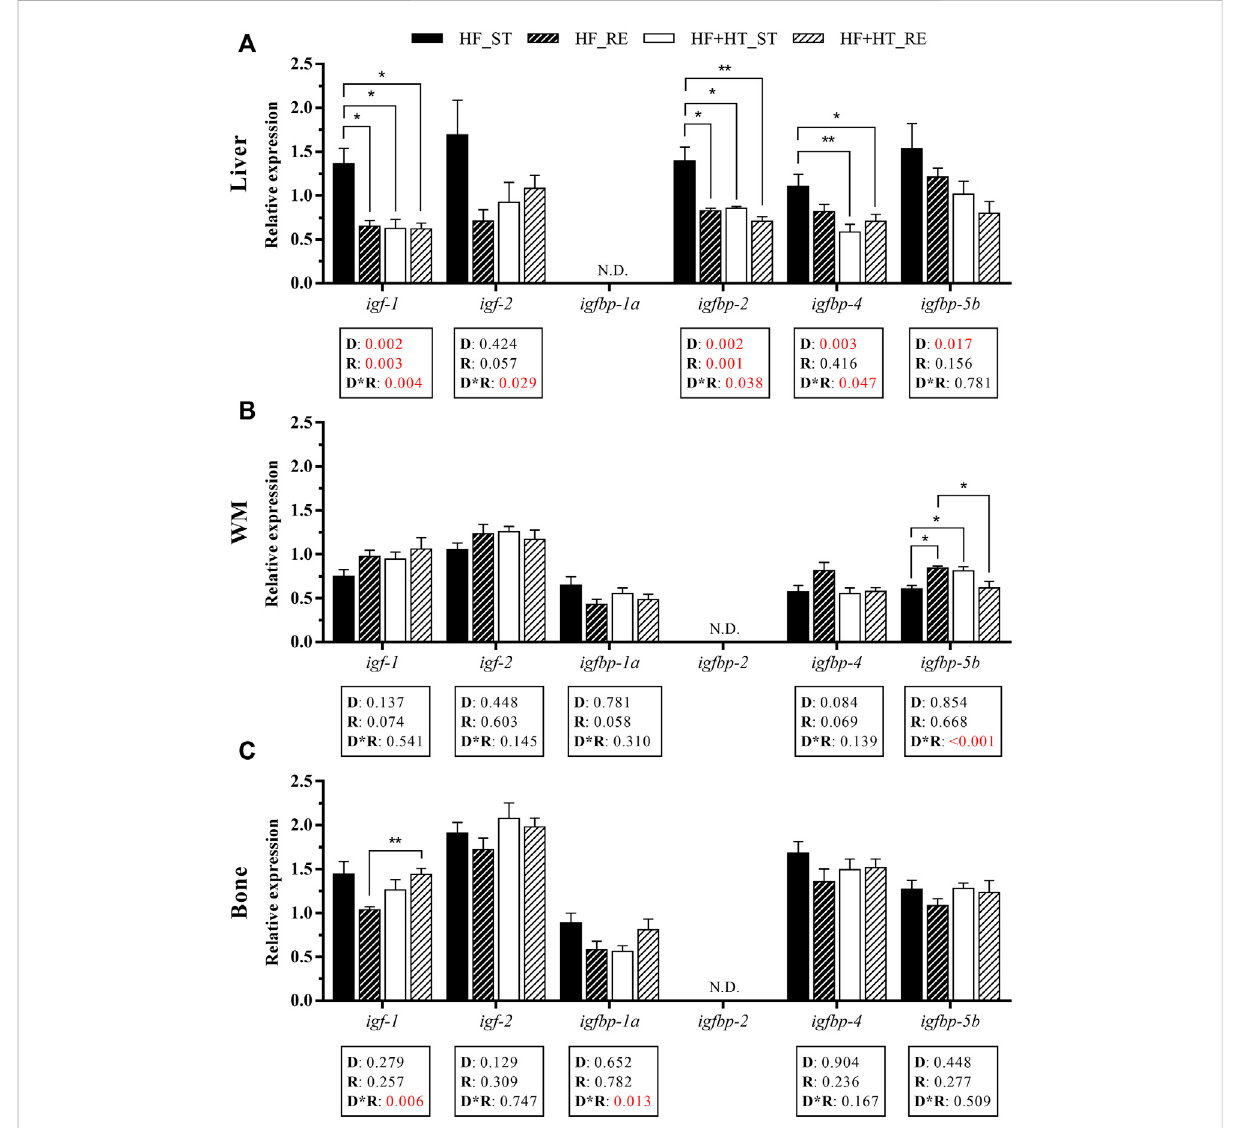
FIGURE 2 Relativegeneexpressionofinsulin-likegrowthfactors(IGFs)andIGFbindingproteins(IGFBPs)in (A) liver, (B) whitemuscle(WM)and (C) boneof gilthead sea bream juveniles fed with a high-fat diet in the absence (HF) or presence (HF + HT) of hydroxytyrosol (0.52 g HT/kg feed), at a standard (ST) (3% biomass/tank) or restricted ration (RE) (40% daily reduction) for 8 weeks. Data are shown as Mean + SEM ( n = 10). Statistical differences are indicated in 3 components: diet (D), ration (R) and interaction (D*R), using two-way ANOVA ( p < 0.05, showed in red). When the interaction between thetwo factors (D*R) was signi fi cant, comparisons among groups were analyzed by aTukey ’ spost-hoctest and,signi fi cant differences are indicated by asterisks ( p < 0.05 shown as *; p < 0.01 **). N.D.,